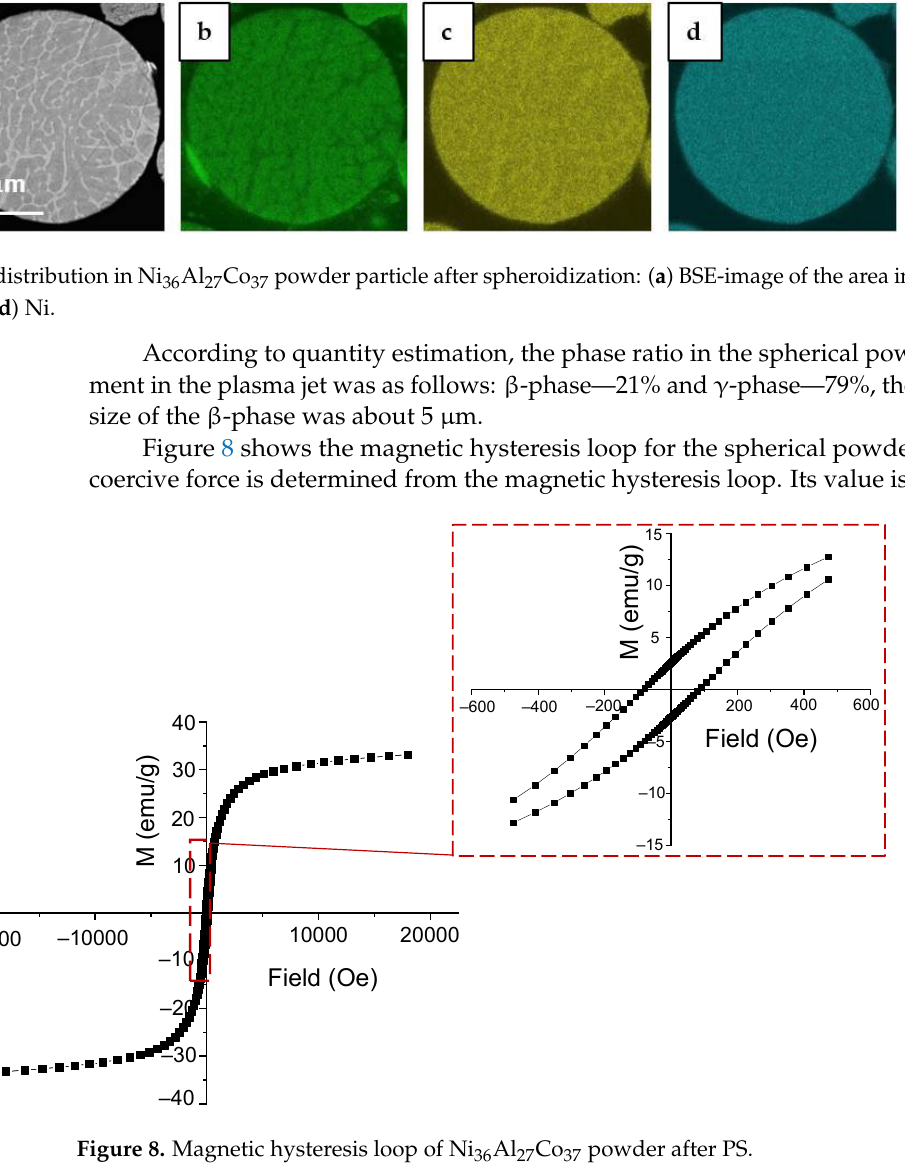
Figure 6. X-ray diffraction pattern and micrograph of Ni 36 Al 27 Co 37 powder after plasma spheroidization.